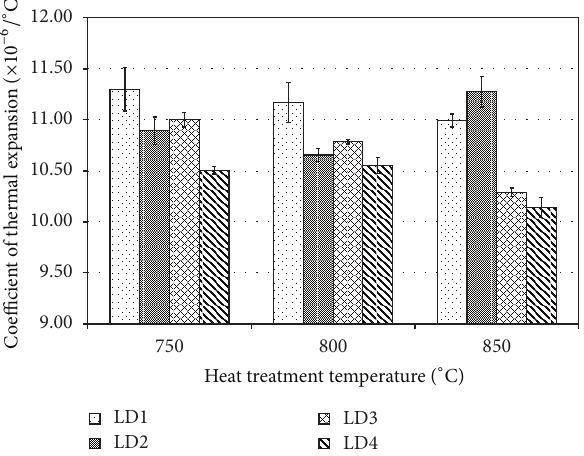
Figure 3: The coefficient of thermal expansion of LD1, LD2, LD3, and LD4 which were heat-treated at 750–850 ∘ C for